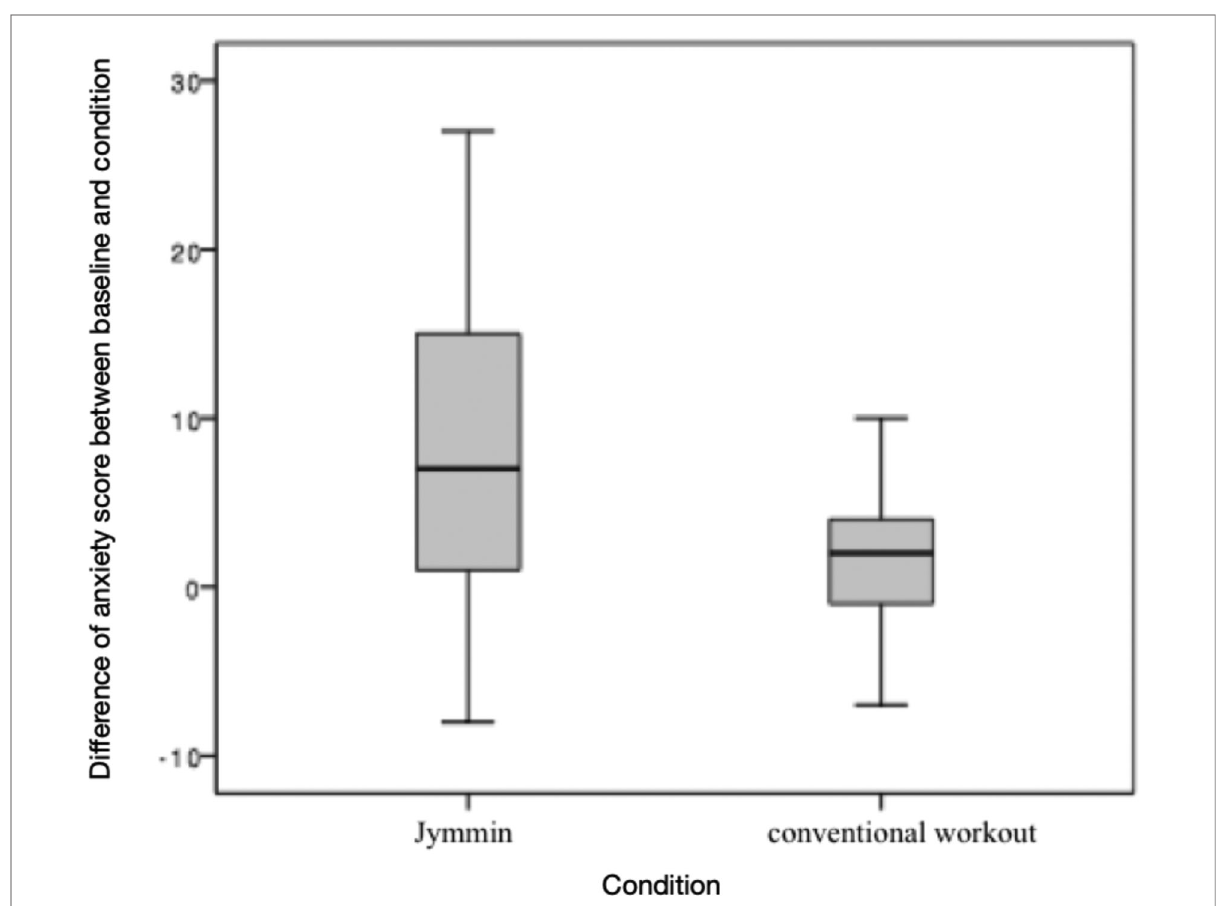
FIGURE 3 The fi gure depicts differences of baseline anxiety scores and the anxiety scores after Jymmin or conventional workout condition as measured with the STAI . A Wilcoxon Signed Rank Test revealed a signi fi cant difference between medians of the difference between baseline and the Jymmin condition, and the difference between baseline and the conventional workout condition. Anxiety total scores declined stronger after the Jymmin condition as compared to the conventional workout